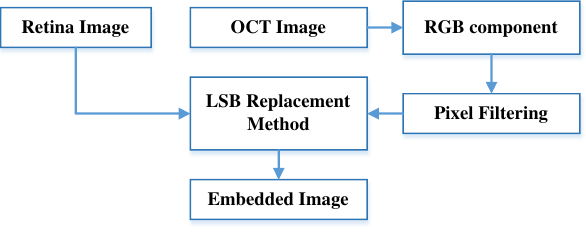
Fig. 4. Algorithm of